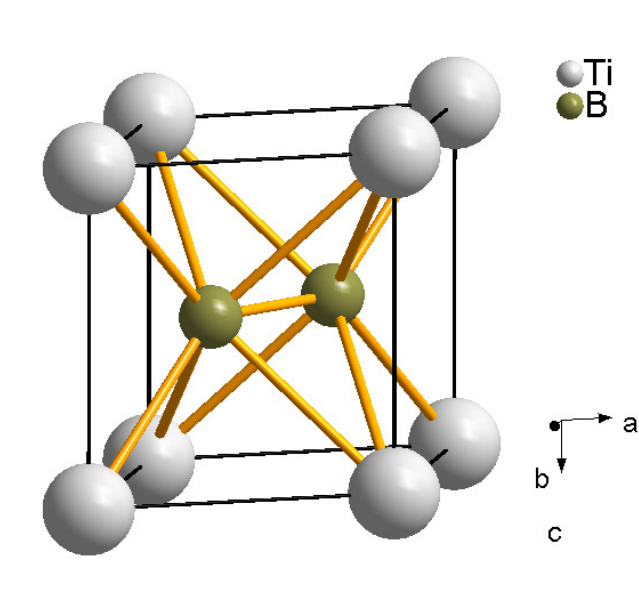
of AlB structure 2 2